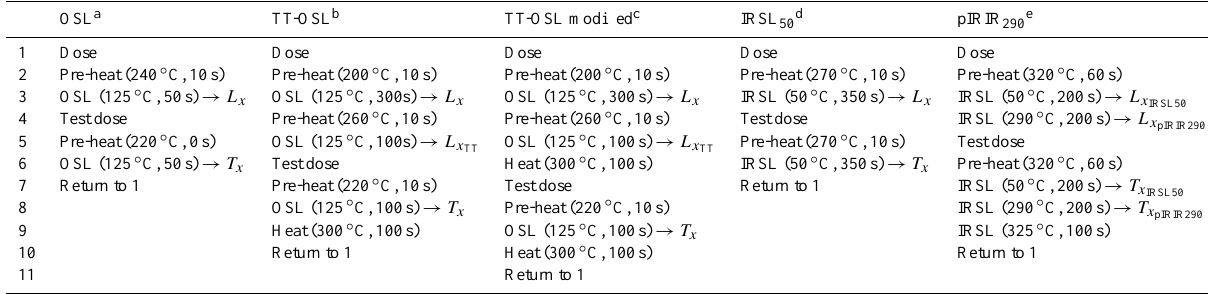
Table 2. Compilation of measurement protocols used in this study.